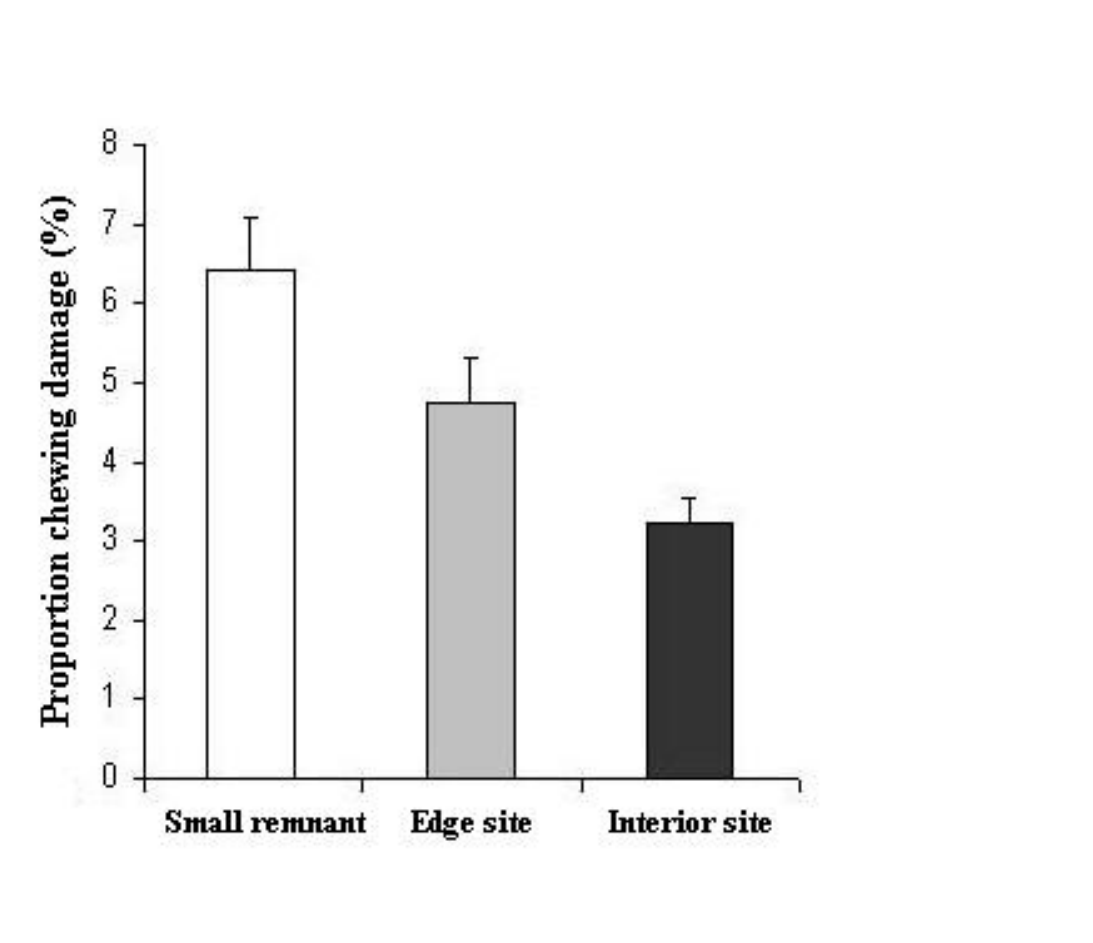
Fig. 2. Total proportion chewing damage (+ SE) for small remnants, edge, and interior site treatments ( n =